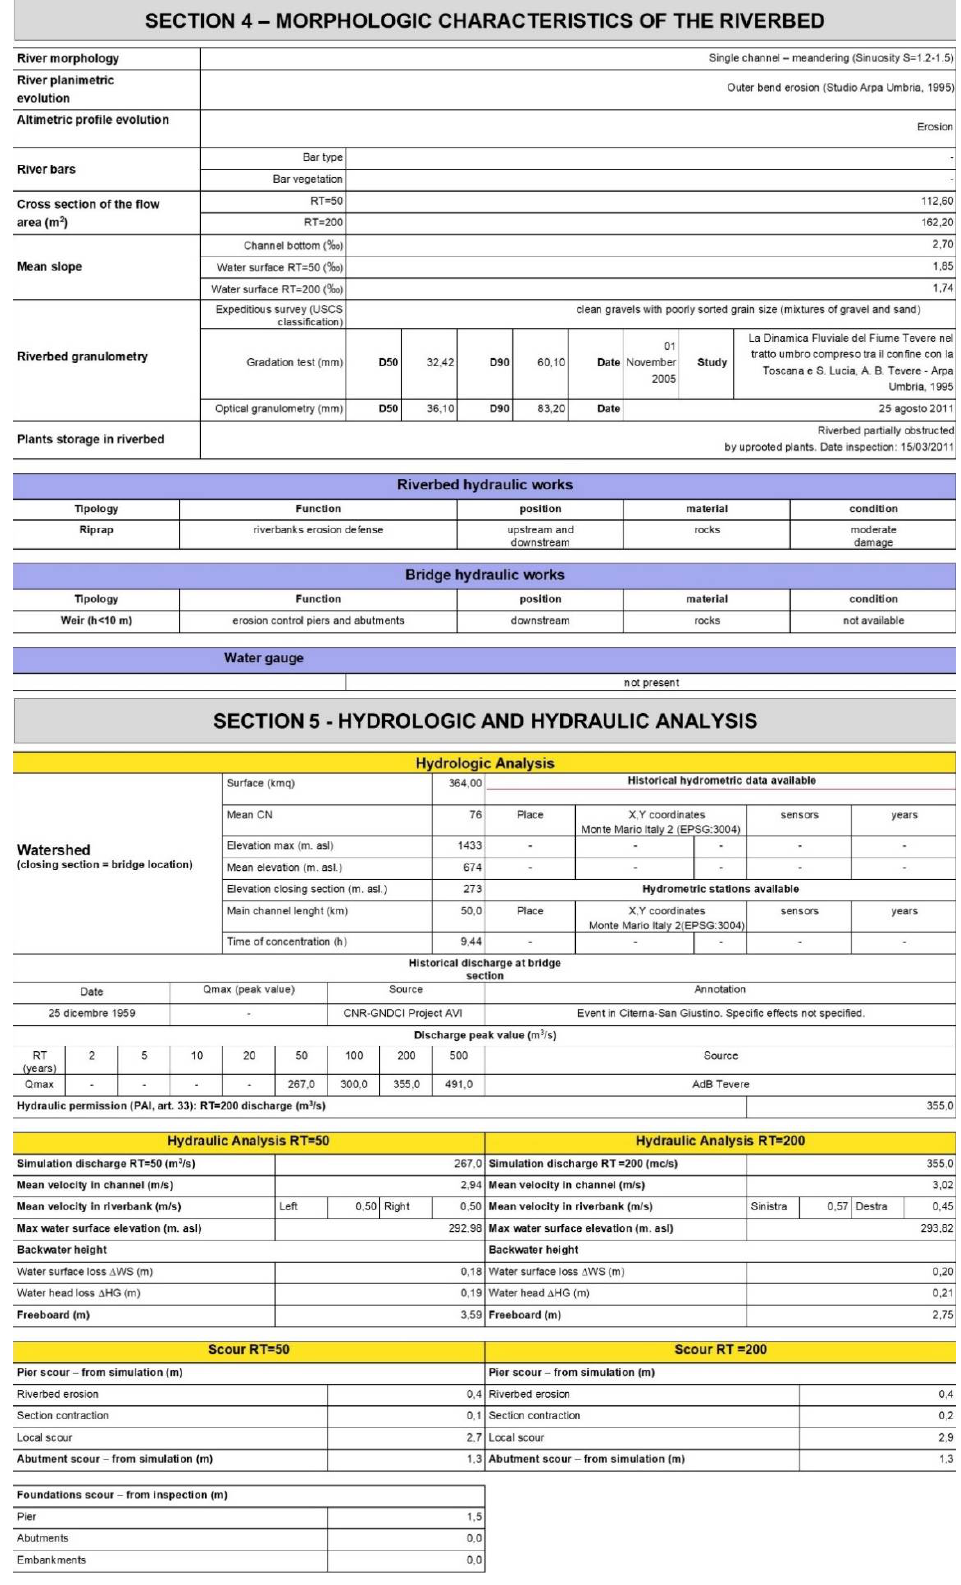
Figure A3. Synoptic table for Sections 4 and 5.